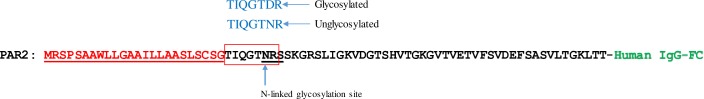
Determination of the N-terminal sequence of PAR2 mature protein.The N-terminal extracellular region of PAR2 is fused to the N-terminus of IgG-Fc. The predicted signal peptide of PAR2 is shown in red and underlined. The IgG-Fc region is shown in green. The potential N-linked glycosylation site, NRS, is underlined. The protein is expressed in COS7 cells and affinity purified. The N-terminus of the purified protein was determined by MS sequencing after trypsin digestion. Two sequences have been observed: TIQTNR and TIQTDR representing unglycosylated and glycosylated PAR2 N-termini.